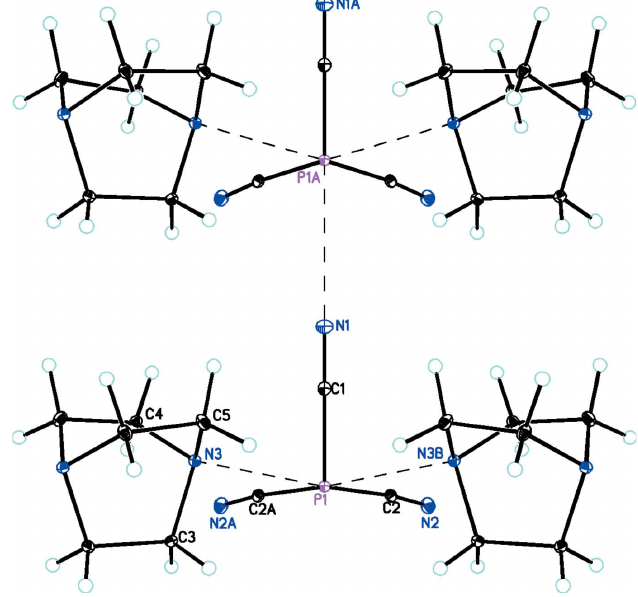
Figure 2 Diagram for 1 showing the interaction of P1 with N1 (shown as dashed lines), forming chains along the a- axis direction. Atomic displacement parameters are at the 30% probability level. The symmetry code for the